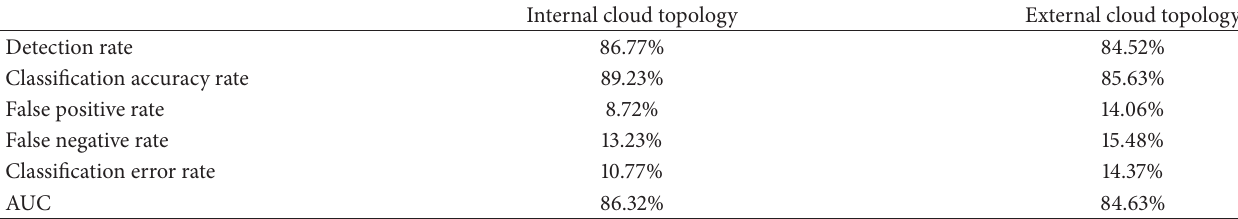
Table 7: MADM performance results in cloud environment using 4D